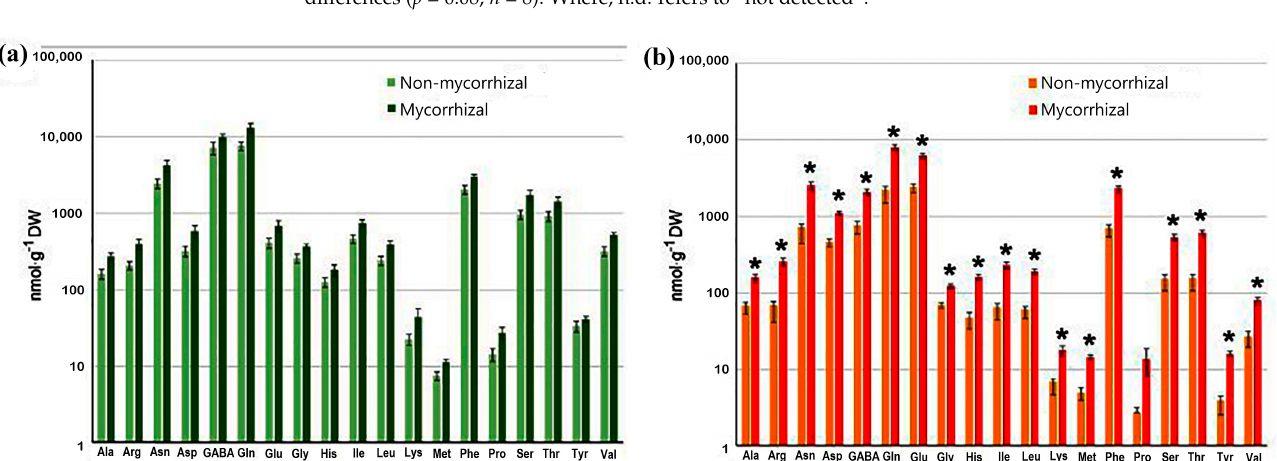
Carotenoids were measured using HPLC and are expressed as ng mg − 1 of dry weight. The fruits from non-mycorrhized ( − AM) and mycorrhized (+AM) plants did not signi fi cantly di ff er from one another, and are presented as means ± SD. BRIX values of red fruits with and without mycorrhizae. BRIX was calculated using temperature-adjusted solids percentage. Between the two data sets, Student’s t -tests found no discernible differences ( p = 0.08, n = 8). Where, n.d. refers to “not detected”.